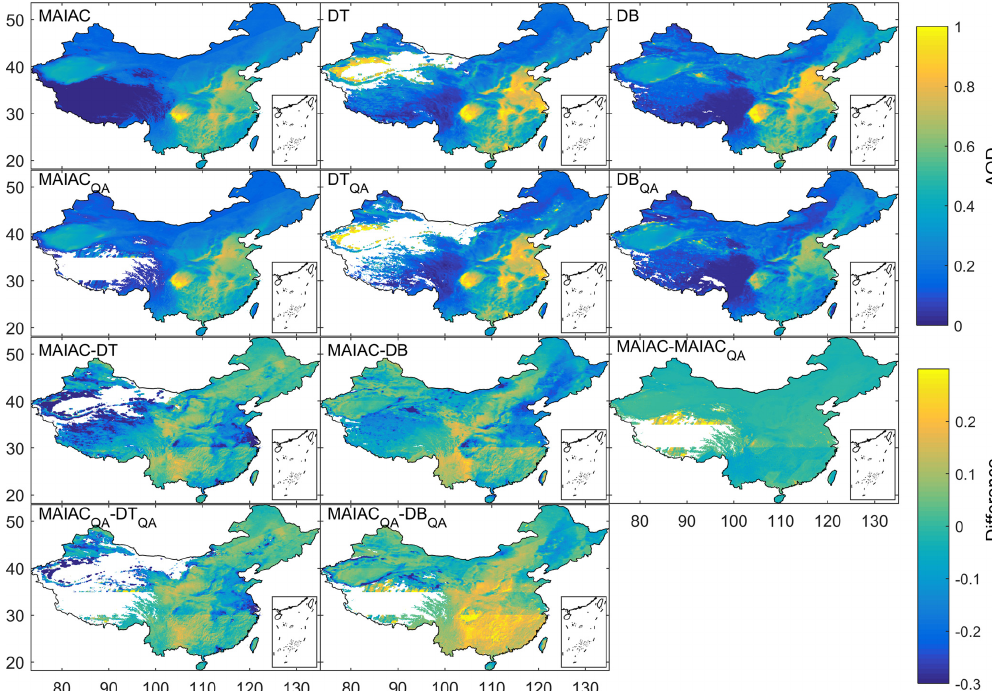
Figure 13. Averaged AOD distributions throughout the year for MAIAC, DT, and DB before the QA filter and their differences after the QA filter from 2000 to 2017. The subscript QA denotes the corresponding results after the QA